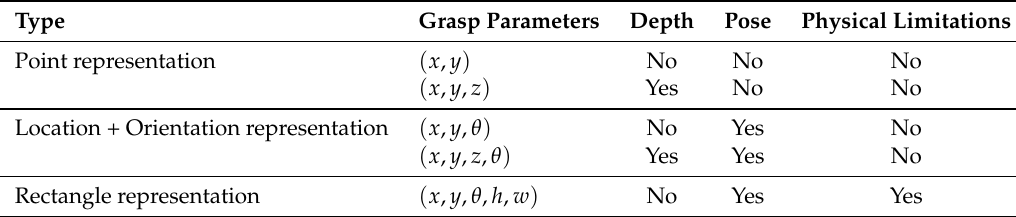
Table 1. Comparison between different grasp